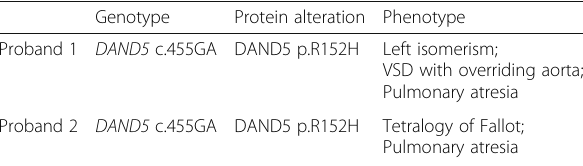
Table 2 Clinical and molecular findings of patient 1 and 2 Genotype